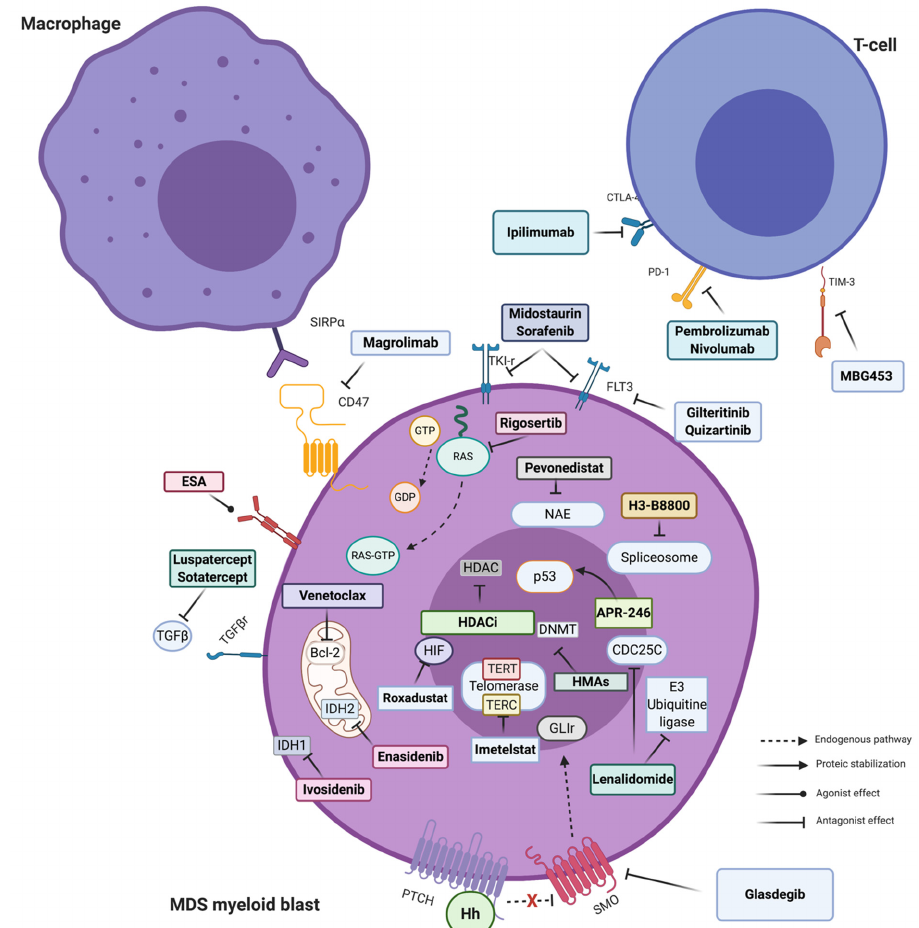
Figure 1. Principal targeted therapies available in MDS. Stylized pathways are also indicated. The arrow and connector style indicate the type of molecular effect. Majority of targeted drugs have an antagonist effect and work inhibiting a more or less specific enzymatic/proteic function. Exceptions are represented by erythropoietin stimulating agent (ESA) (agonists of Erythropoietin (EPO) receptor, not discussed here in detail) and APR-246, the new p53-mutated targeted agent, able to refold the aberrant protein restoring its transcriptional activity. For description of each mechanism of action see text. Figure created with BioRender . Abbreviations: SIRP α : Signal regulatory protein alpha; ESA: Erythropoietin stimulating agent; TGF β : Transforming growth factor beta; IDH: Isocitrate dehydrogenase; HDAC(i): Histone deacetylases (inhibitor); Hh: Hedgehog polypeptides; PTCH: Protein patched homolog; SMO: Smoothened; HMA: Hypomethylating agents; DNMT: DNA methyl transferase; NAE: Neural Precursor Cell Expressed, Developmentally Down-Regulated 8 (NEDD8)-activating enzyme; GTP: guanosine triphosphate; GDP: Guanosine 5 ′ -diphosphate; FLT3: FMS-like tyrosine kinase 3; PD-1: Programmed cell death 1; CTLA4: cytotoxic T-lymphocyte-associated protein 4; HIF: Fypoxia inducible factor; TERT: Telomerase reverse transcriptase; and TERC: Telomerase RNA